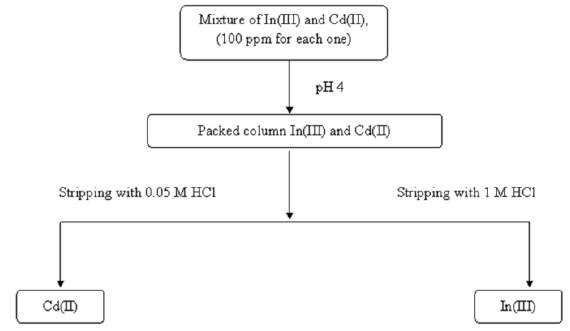
Figure 8. Flow sheet for the separation of In(III) from Cd(II) onto commercial resin, Dowex 50w-x8.